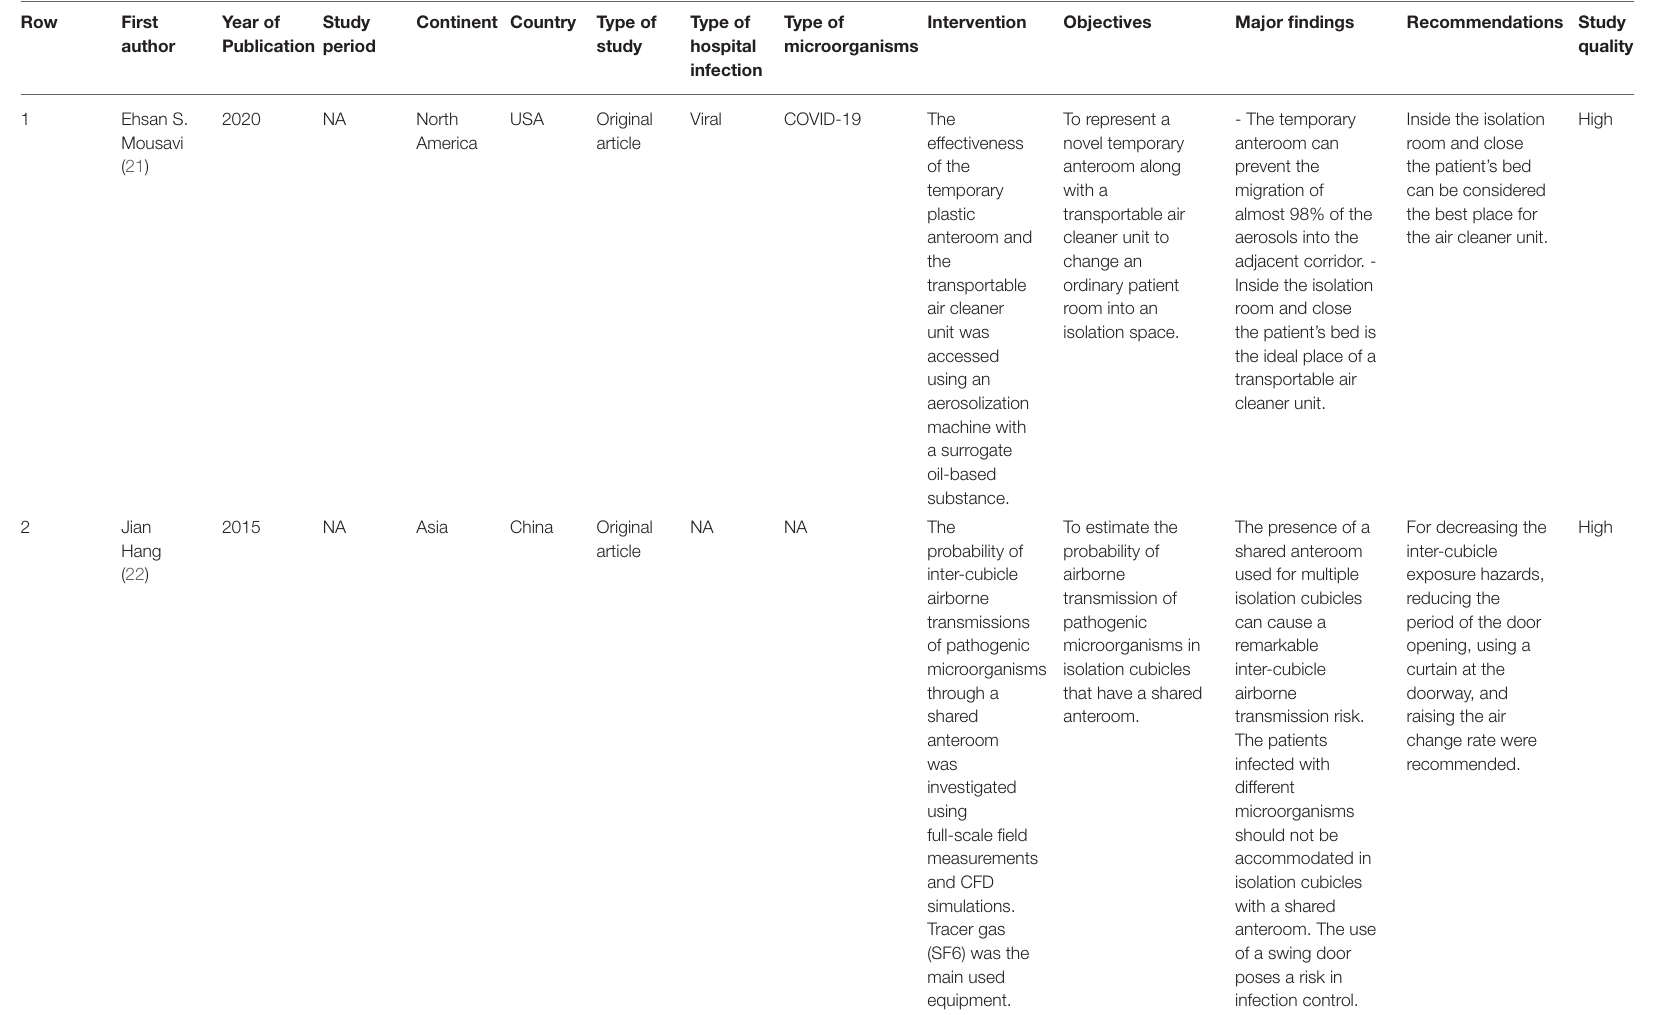
TABLE 1 | The detailed information presented in the 25 included